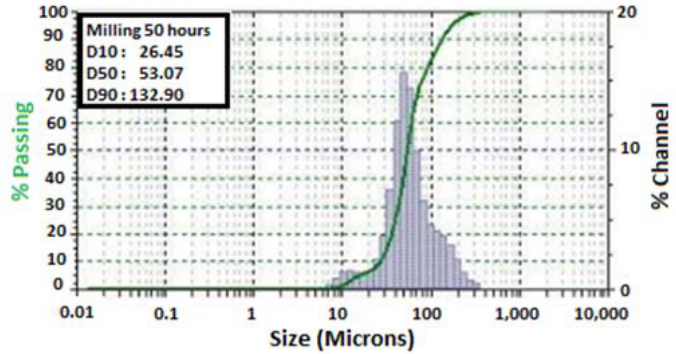
Figure 4. Parameters D10, D50 and D90 and average particle size after high energy milling for 50 h.